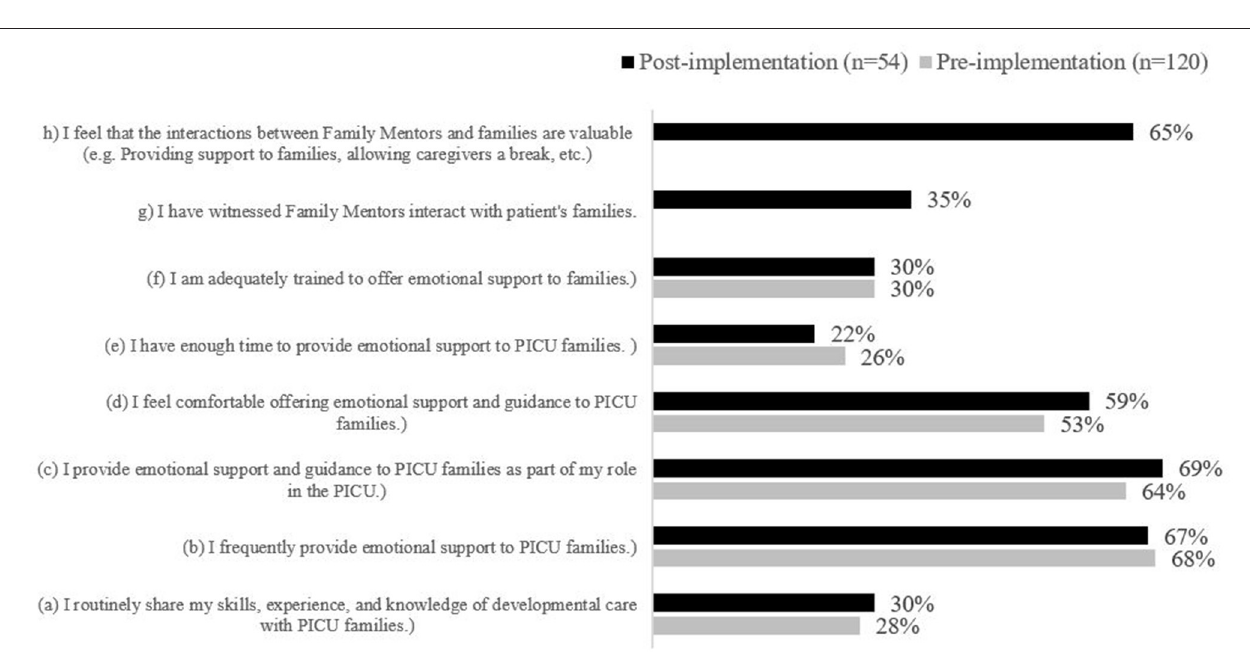
FIGURE 5 | Staff Level of Agreement with Statements regarding the Family Mentor Program. Statements (g) and (h) were not included as survey items in the staff pre-implementation survey; therefore, no data is